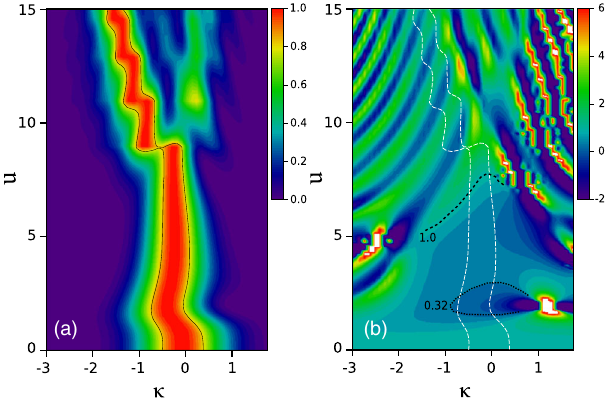
FIG. 3. Power spectrum (a) and group velocity (b) correspond- ing to the case of Fig. 1(a) vs u , κ . The power P is normalized at each position in u . The white dashed line in (b) represents the power contour line, in black in (a), corresponding to the level ≃ 0 . 8 . The black dotted and dashed contour lines in (b) delimit ∼ 1 = 3 ) and to post- the transitions to exponential regime ( v g > 1 saturation (at u ∼ 7 – 8 ) where v g